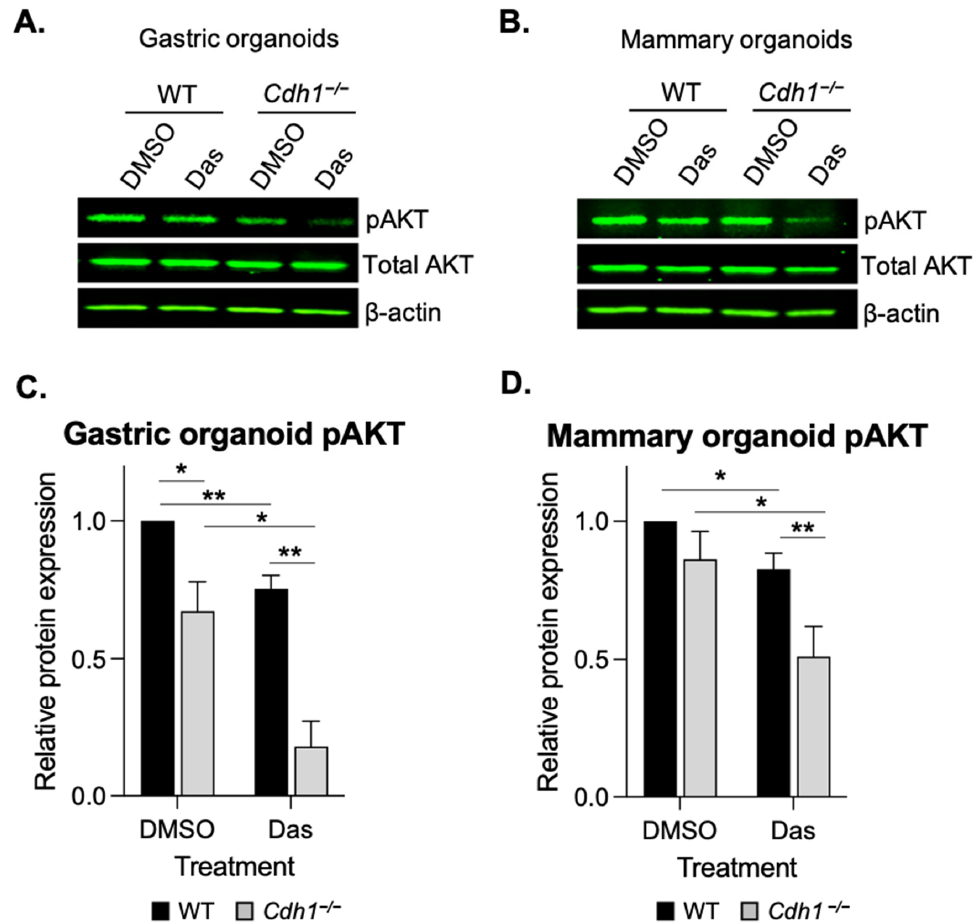
Figure 5. Dasatinib preferentially inhibits pAKT in mouse derived organoids lacking Cdh1 − / − . ( A , B ) Western blots of pAKT-Ser473 and total AKT levels in gastric ( A ) and mammary ( B ) organoids treated with DMSO or dasatinib (0.5 µ M) for 24 h. ( C , D ) Relative expression of pAKT gastric ( C ) and mammary ( D ) organoids. (For all graphs, error bars = SEM; * p < 0.05, ** p < 0.01; n ≥ 3 independent biological replicates; unpaired two-sided t -test).